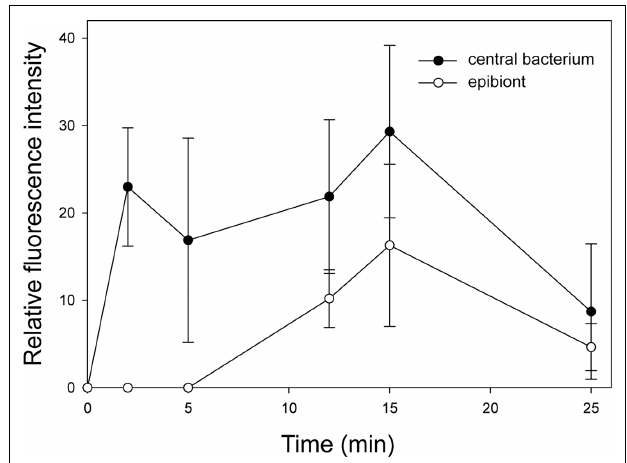
FIGURE 2 |Time course of fluorescence intensities of CFDA-SE stained central bacteria and epibiont